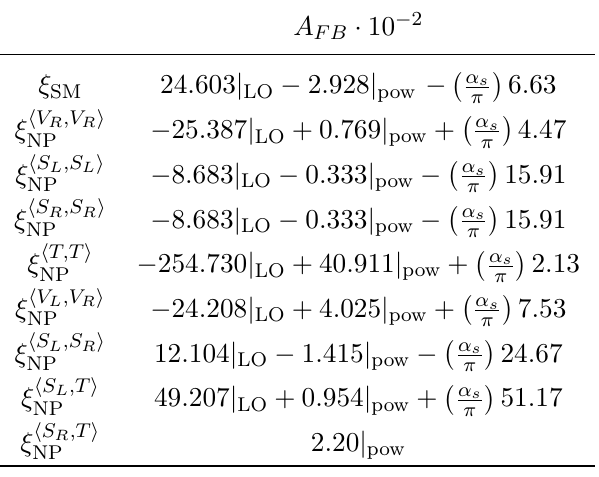
Table 4. Numerical values of the parameters for the A FB given in eq. (3.1). We consider q 2 4 GeV 2